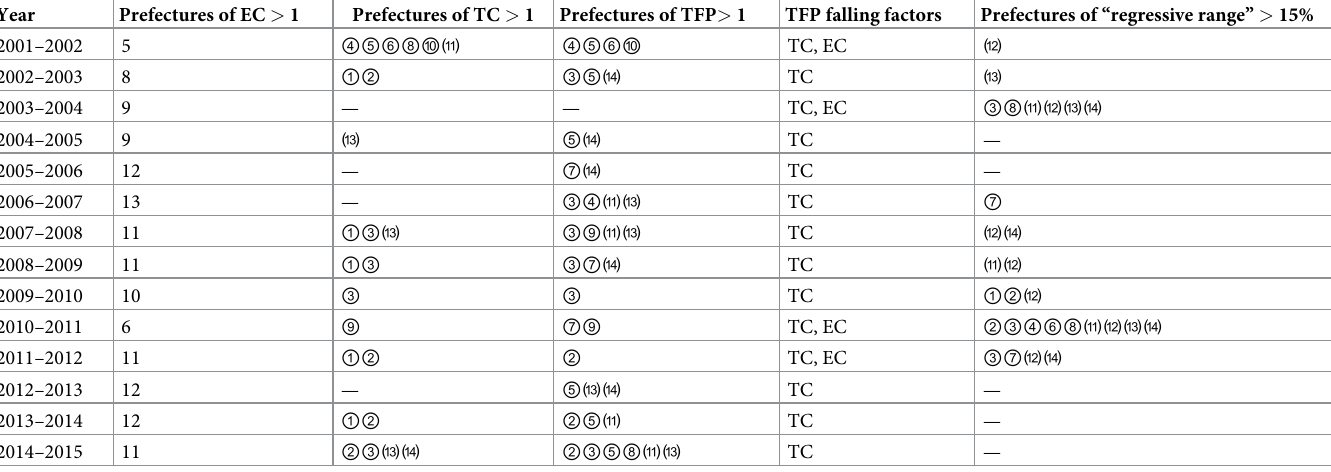
Table 6. Comprehensive statistical table of the Malmquist index in Xinjiang from 2001 to 2015. Year Prefectures of EC >